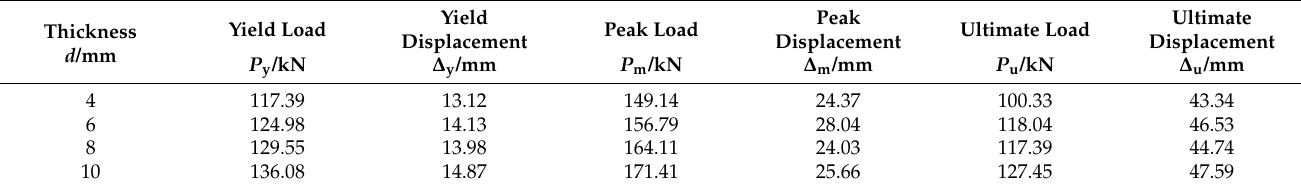
Table 7. Influence of profile web thickness on characteristic points of composite joints.